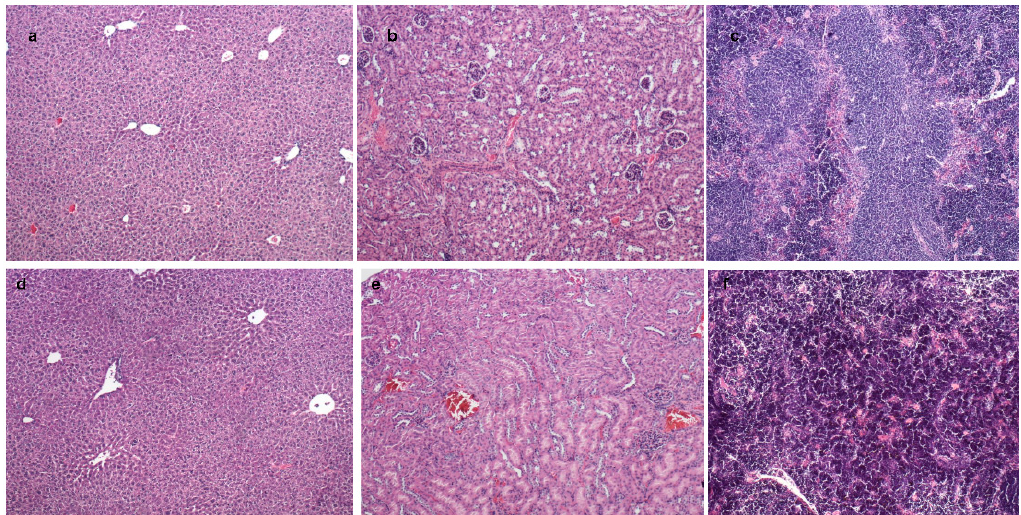
Figure 10. Histopathology of liver ( a ), kidney ( b ) and spleen ( c ) in SLN-TMZ group mice; liver ( d ), kidney ( e ) and spleen ( f ) in control group mice (haematoxylin and eosin, 100 × ).